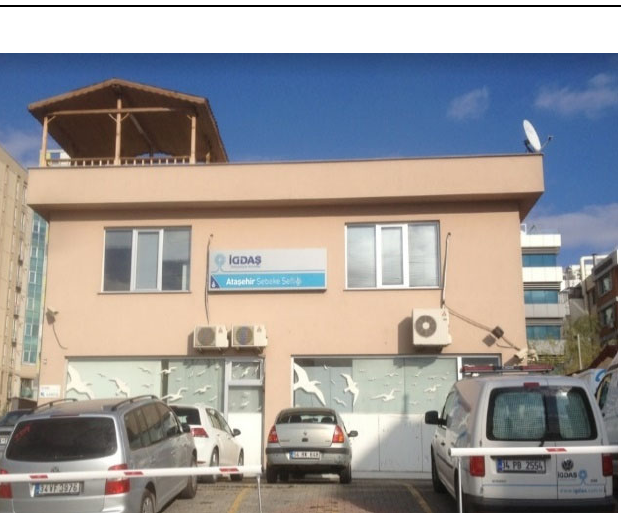
Figure 3. Natural gas emergency response team center building in Ata ş ehir natural gas intervention zone.